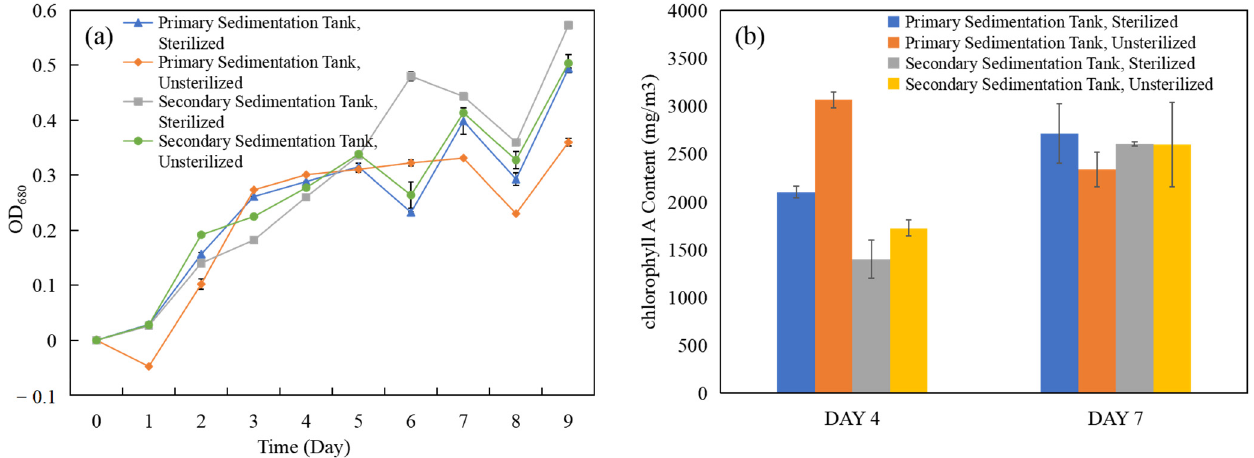
Figure 4. ( a ) Growth curve of Scenedesmus dimorphus under different wastewater qualities (i.e., PTS, PTU, STS, and STU) characterized by OD 680 . ( b ) The chlorophyll a content of Scenedesmus dimorphus under different wastewater qualities at day 4 and day 7 ( n = 3).